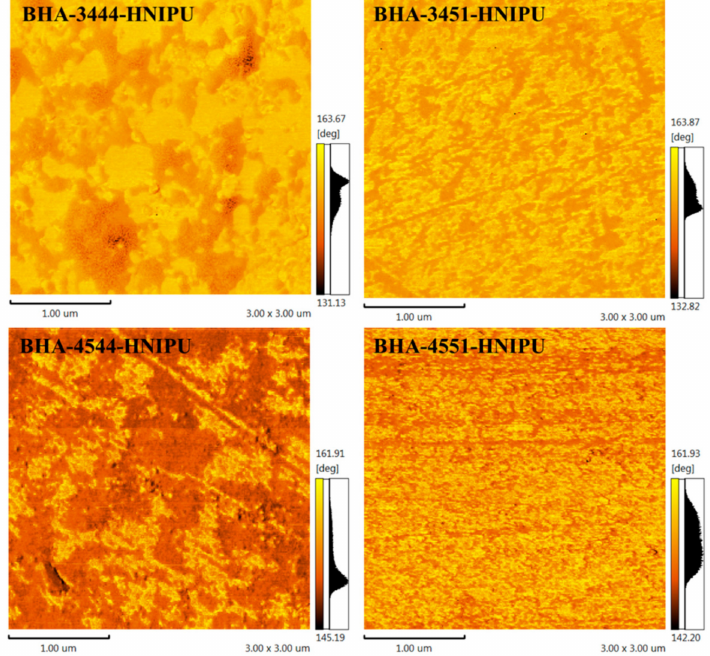
Figure 14. Surface morphology of HNIPUs characterized by AFM phase imaging.